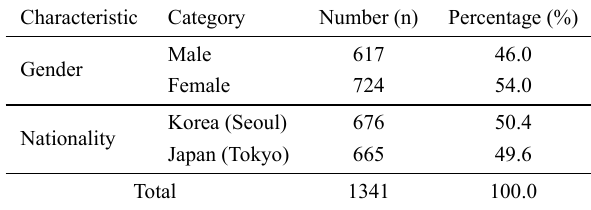
Table 1. Participants’ demographic